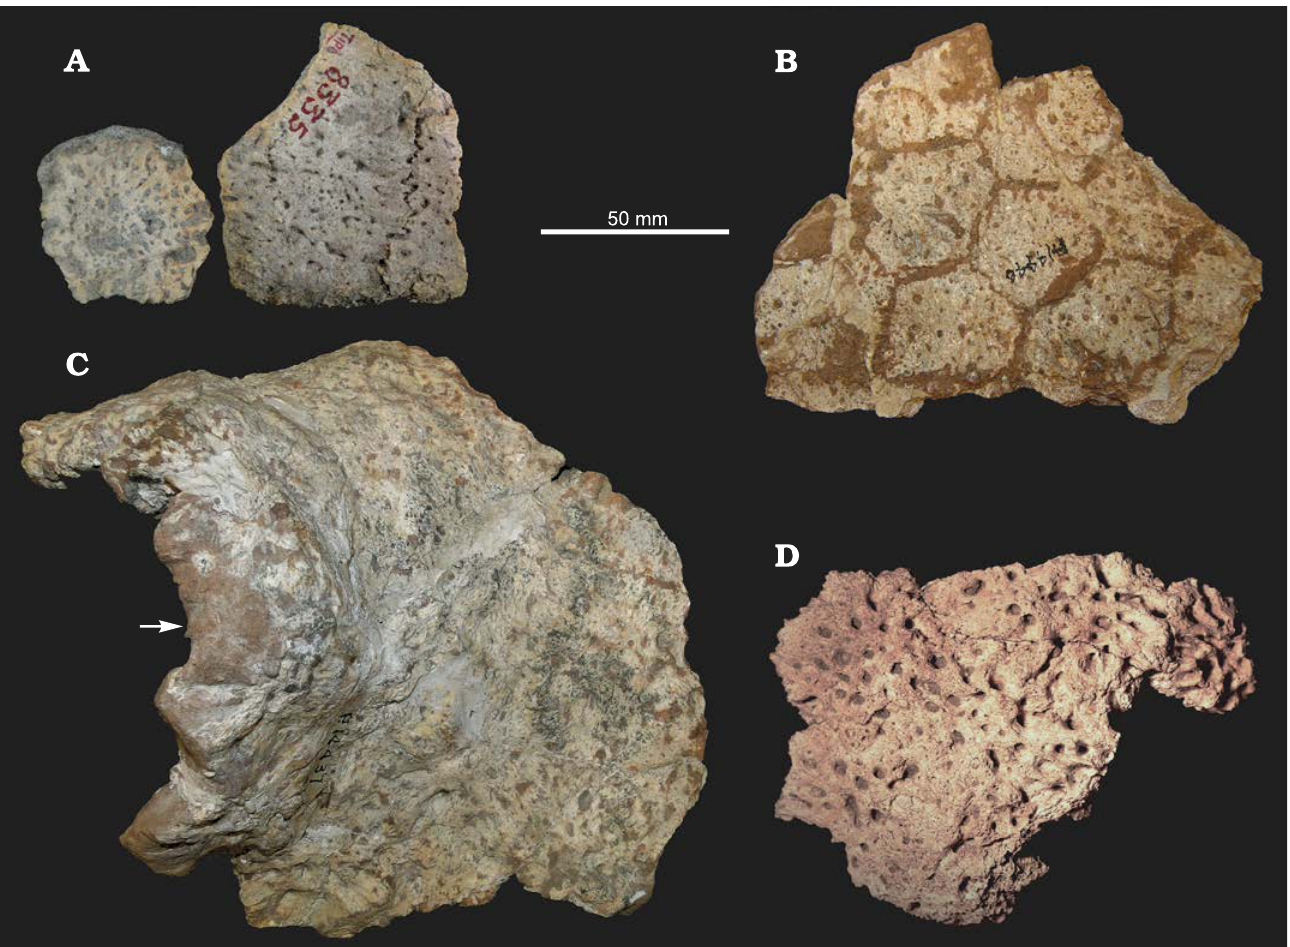
Fig. 6. Osteoderms of doedicurine glyptodont Eleutherocercus solidus (Rovereto, 1914) from Pliocene of Argentina. A . MACN 8335 (holotype), small carapace fragment, from Andalhuala, “Araucanian” (late Neogene). B . FMNH-P 14446, carapace fragment (middle or cephalic region), from Puerta de Corral Quemado, Corral Quemado Formation, level 32. C . FMNH-P 14437, carapace fragment (the arrow is pointing the postero-dorsal region showing the modified osteoderms that constitute the “dome” structure), from Puerta de Corral Quemado, Andalhuala Formation, levels 23–28. D . MCH-P 188, small fragment of carapace, from San Fernando Norte, Andalhuala